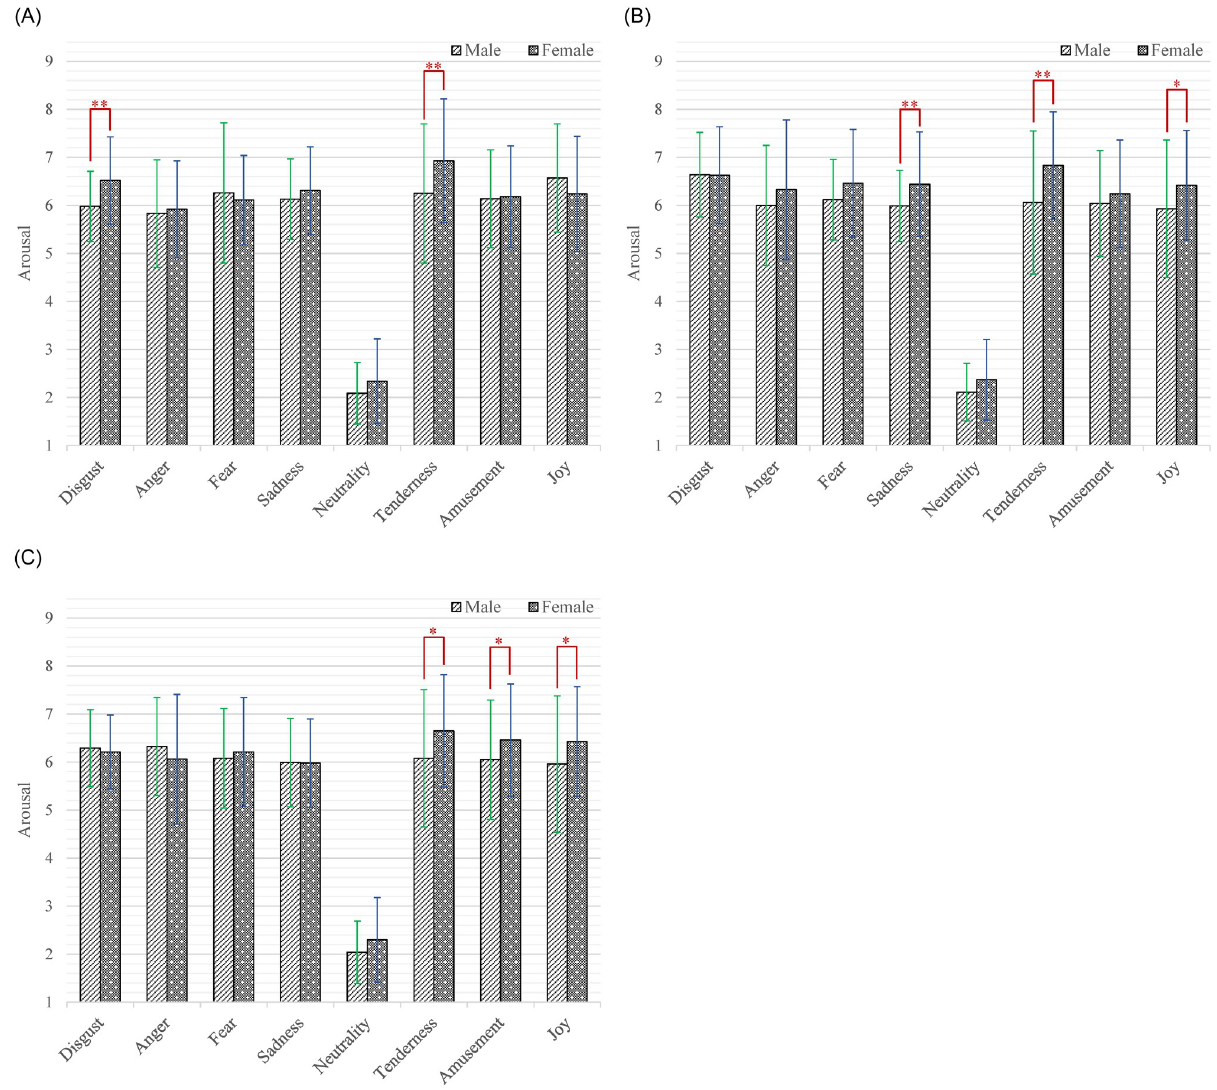
Fig 8. The arousal scores of each category of emotion-inducing short videos between male and female. A: Age = 20–24. B: Age = 25–29. C: Age = 30–34. Statistical significance: * p < 0.05, ** p < 0.01, *** p < 0.001. Unless marked with the asterisk, no significant differences between these groups were